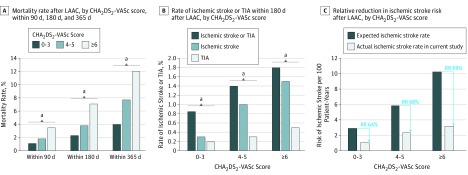
Mortality, Rate of Ischemic Stroke and Transient Ischemic Attack (TIA), and Relative Reduction in Ischemic Stroke Risk After Left Atrial Appendage Closure (LAAC) According to CHA2DS2-VASc ScoreA, Mortality rates within 90, 180, and 365 days after LAAC are shown according to CHA2DS2-VASc (congestive heart failure; hypertension; ages ≥74 years [2 points]; diabetes; stroke, transient ischemic attack, or systemic embolism [2 points]; vascular disease; ages 65-74 years; sex [female]) score. B, Rate of ischemic stroke or TIA within 180 days after LAAC according to the CHA2DS2-VASc score is shown. C, Relative reduction (RR) in ischemic stroke risk after LAAC according to the CHA2DS2-VASc score is shown. For CHA2DS2-VASc score of 0 to 3, the expected ischemic stroke rate was 2.90 and the actual rate was 1.05 per 100 patient-years; for CHA2DS2-VASc scores of 4 to 5, the expected ischemic stroke rate was 5.84 and the actual rate was 2.31 per 100 patient-years; and for CHA2DS2-VASc scores of 6 or more, the expected ischemic stroke rate was 10.24 and the actual rate was 3.18 per 100 patient-years.aStatistically significant difference (P < .05).